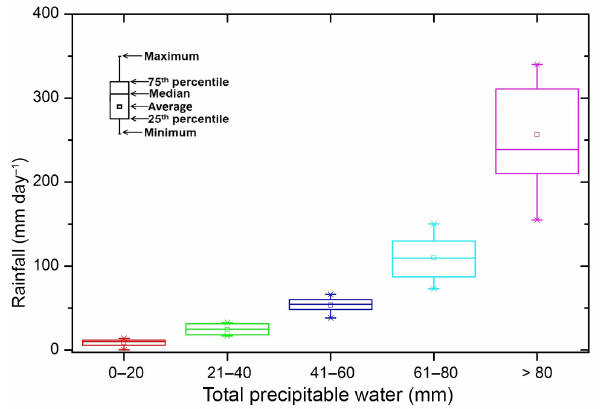
Figure 6. The box–whisker plot for comparison of INSAT-3D TPW with actual rainfall over the Indian